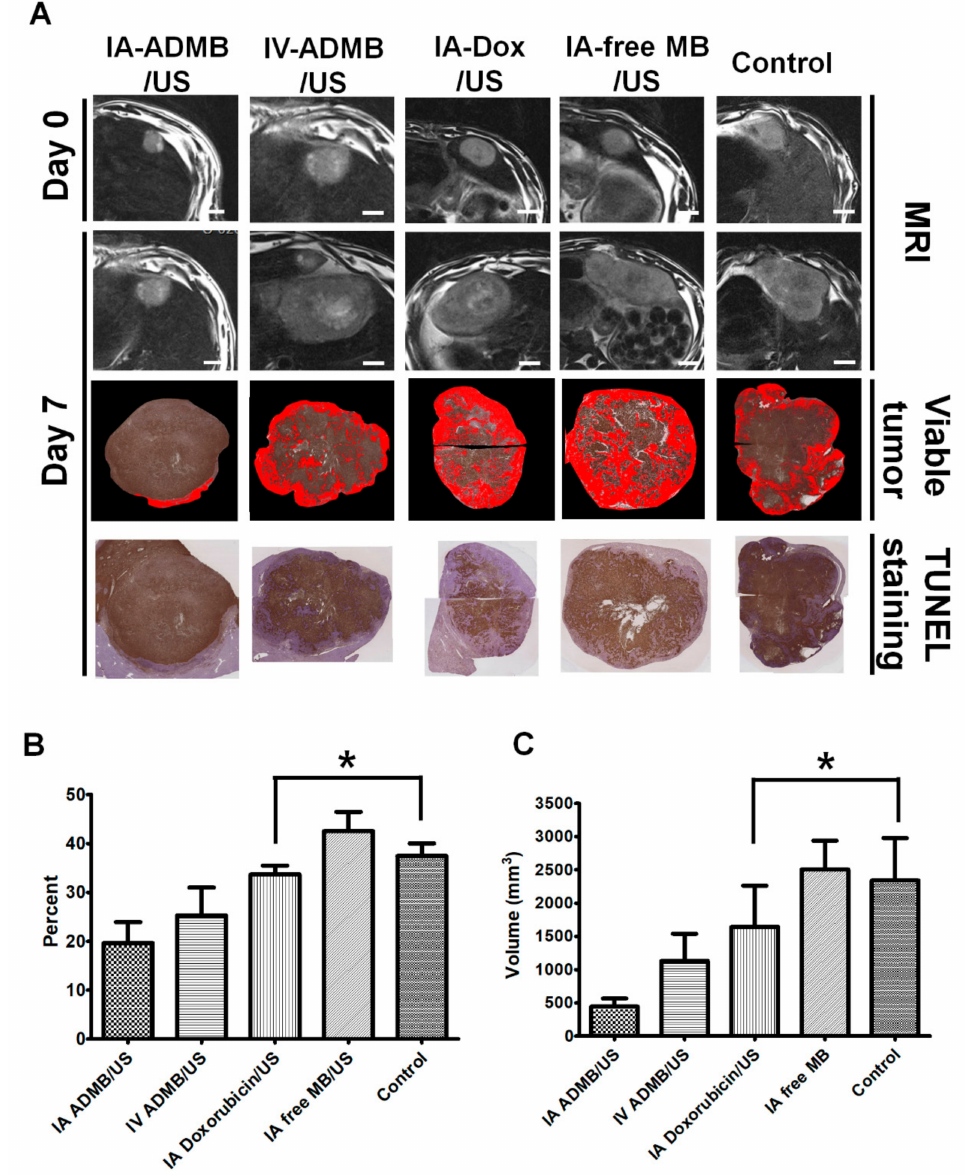
Figure 8. Representative MRI and histo-segmentation images of each group, Scale bar: 10 mm ( A ). Quantitative analysis of viable tumor fraction ( B ). Estimated viable tumor volume ( C ) at day 7 after treatment. Red area represents the viable portion of tumor; each bar represents mean SEM., * p < 0.05 versus IA doxorubicin / US, IA free MB / US, and untreated control